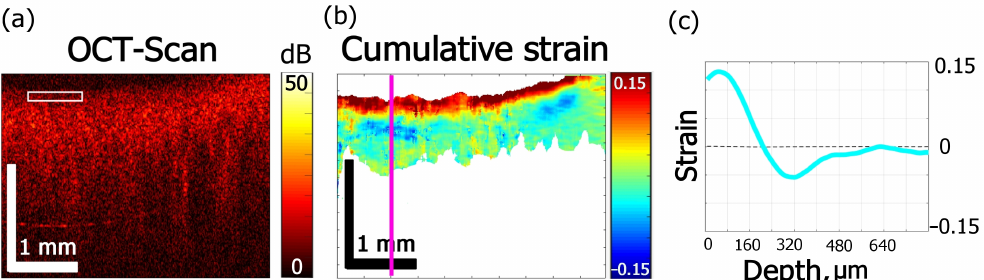
Figure 6. Effects of Omnipaque on strain kinetics and amplitude inside cartilage obtained for 600 s: ( a ) OCT structure image, ( b ) cumulative strain image, ( c ) strain distribution along the line in ( b ).